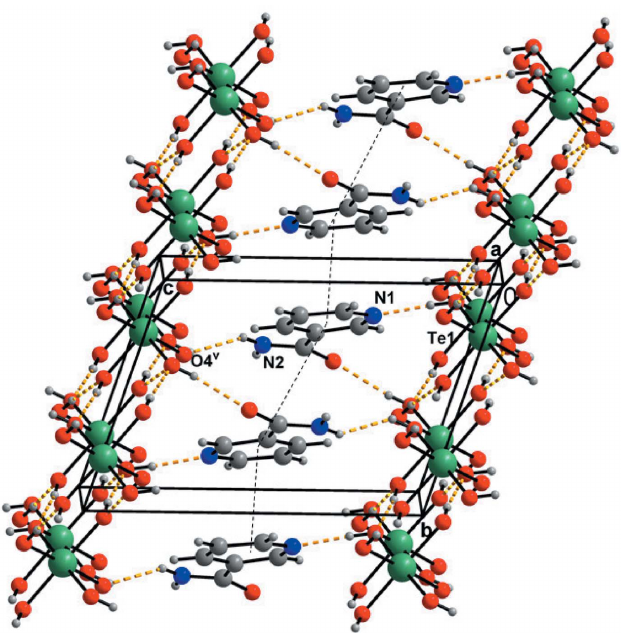
Figure 5 View ( DIAMOND ; Brandenburg & Putz, 2005) of the title structure along the a axis. C, H, N, O and Te atoms are represented by grey, small grey, blue, red and green circles, respectively. Hydrogen bonds are shown as yellow dashed lines. The (cid:2) – (cid:2) electron-ring interactions are indicated by black dashed lines.